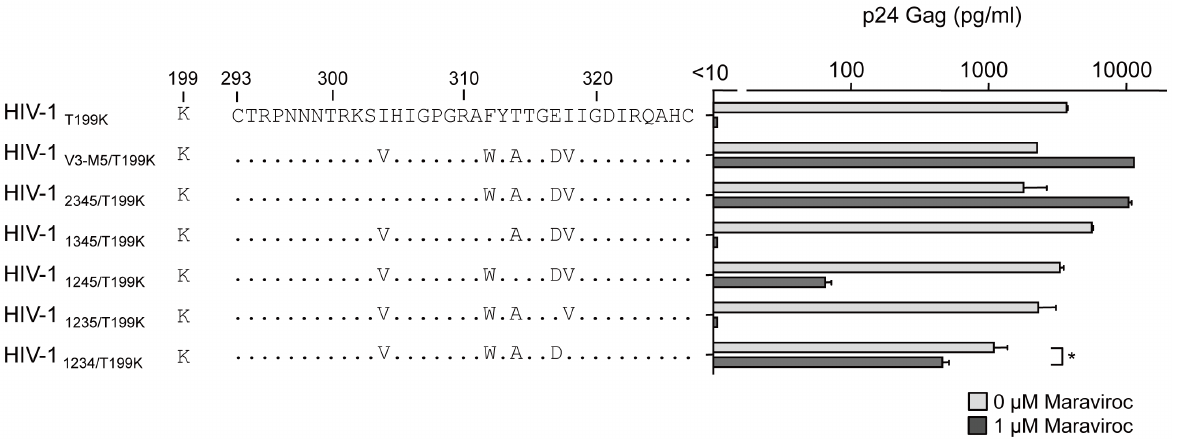
Figure 5. The effect of 1 m M of maraviroc on p24 Gag production in recombinant viruses containing four amino acid substitutions plus T199K. PM1/CCR5 cells (1 6 10 5 ) were infected with 10 ng p24 Gag for 3 h in the presence or absence of 1 m M maraviroc. On day 6 after infection, the amount of Gag in the supernatant was measured by HIV-1 p24 ELISA. The analysis was repeated three times; the error bars represent the S.D. of three replicates from one representative experiment. *, p , 0.05; **, p , 0.01. Statistical significant difference was calculated by t test.